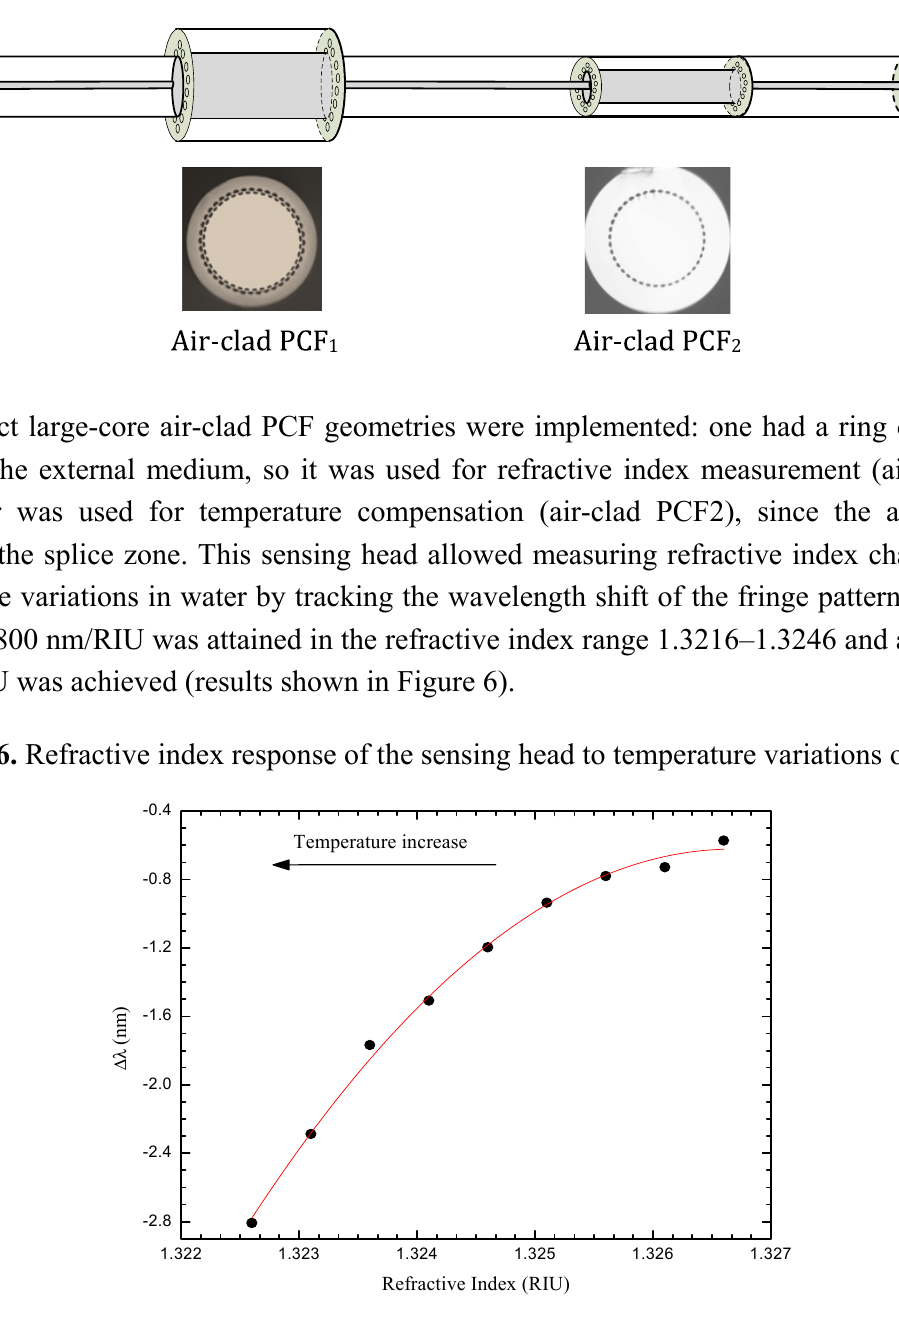
Figure 5. Detail of the PCF-based sensing structure (the cross section of the PCF fibers is also shown). Adapted from [34].